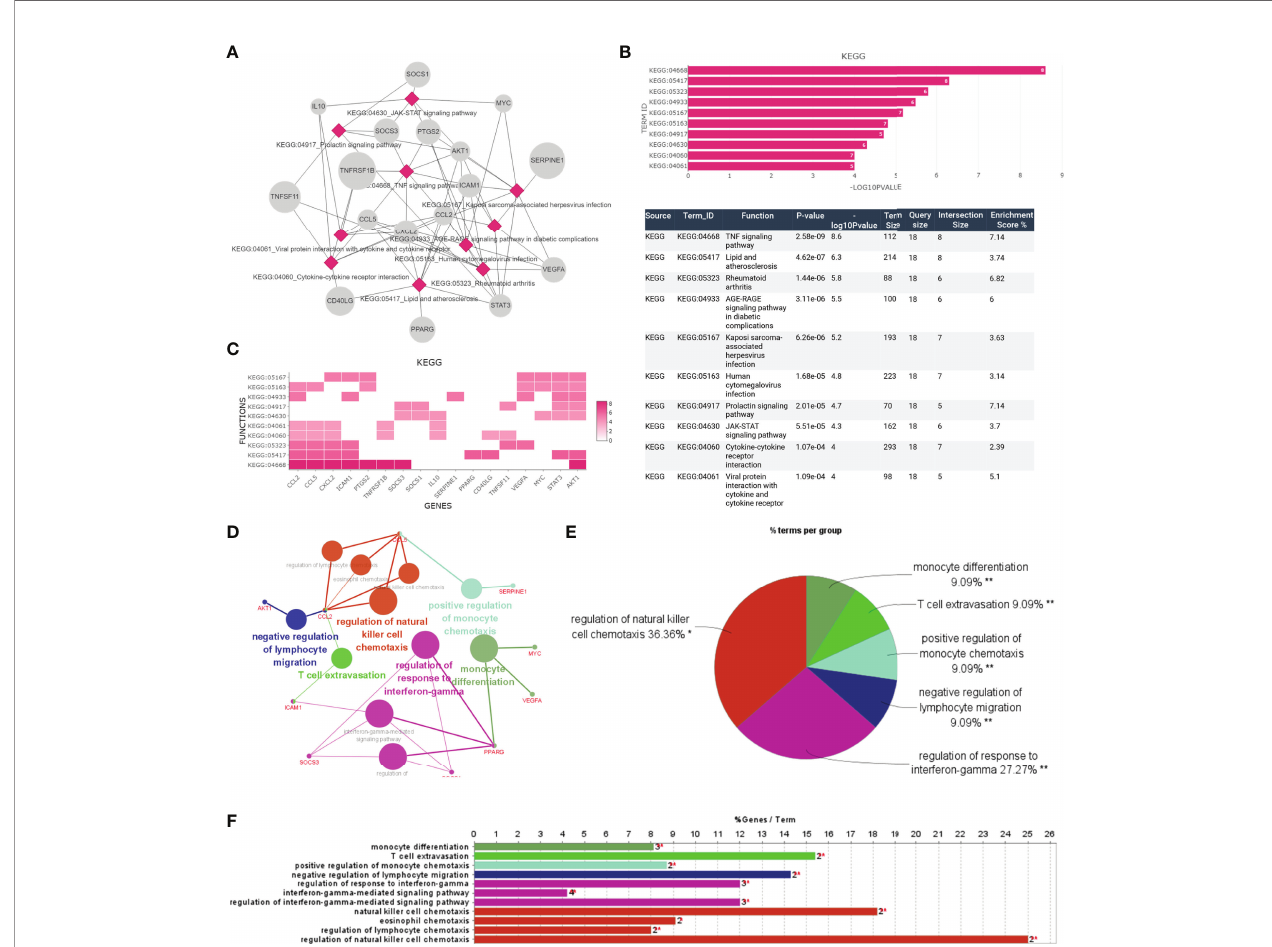
FIGURE 5 | The function analysis of hub genes. (A – C) The most signi fi cant pathway and related genes. The results show that these hub genes are mainly involved in TNF signaling pathway, prolactin signaling pathway, JAK-STAT signaling pathway, and cytokine-cytokine receptor interaction. (D – F) The most signi fi cant immune response and related genes. The results show that these hub genes are mainly involved in regulation of natural killer cell chemotaxis, regulation of response to interferon-gamma. *p < 0.05, **p <